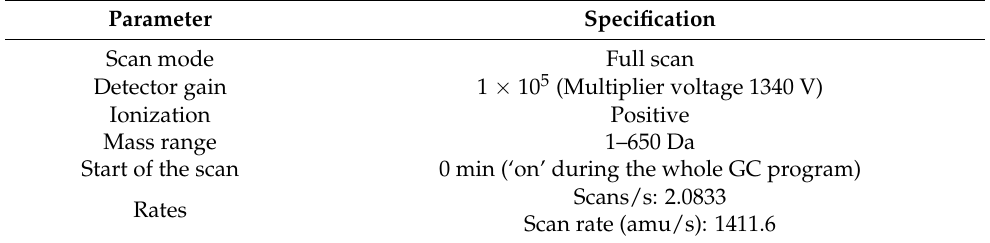
Table 4. MS parameters for all the